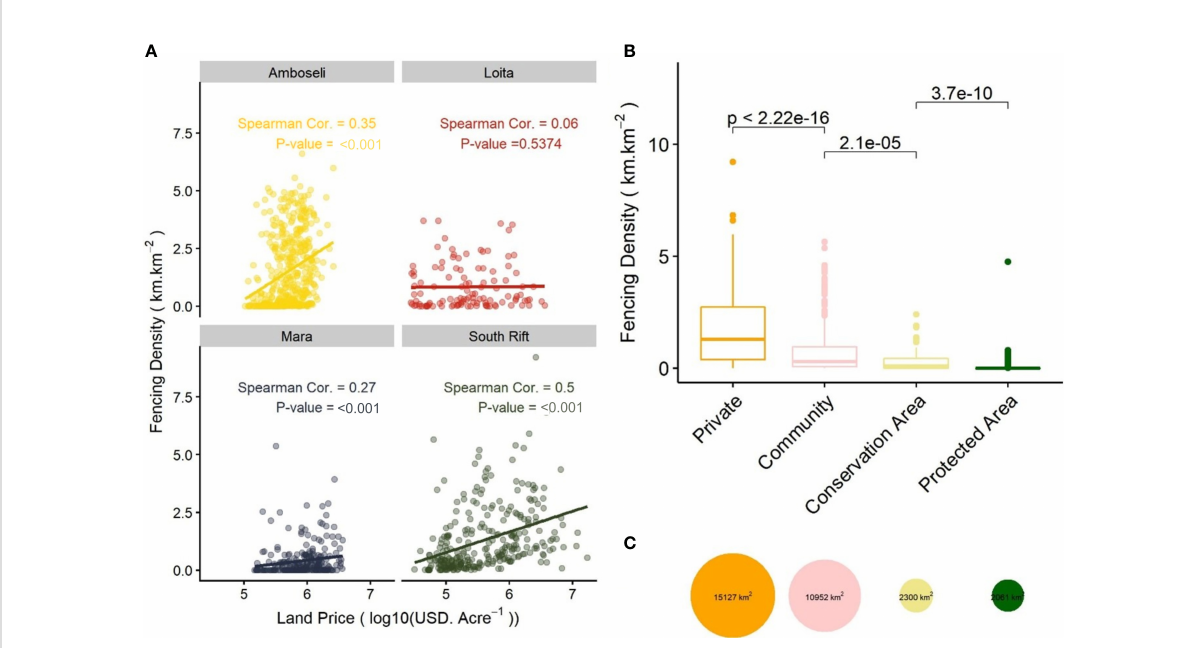
FIGURE 3 (A) The density of fences is positively correlated with the price of land in Amboseli, Mara and South Rift. The effect is strongest in Amboseli and the South Rift, where prices and land conversion are high and driven by the proximity to Nairobi, Kenya ’ s capital, and main roads. (B) Boxplots of fence density in each land-tenure type across the region. Private areas have the highest fence density, followed by community areas, conservation areas, and protected areas. The comparison text indicates p-values from a Kruskal-Wallis test between groups. (C) Bubble plot comparing the total area of each land-tenure